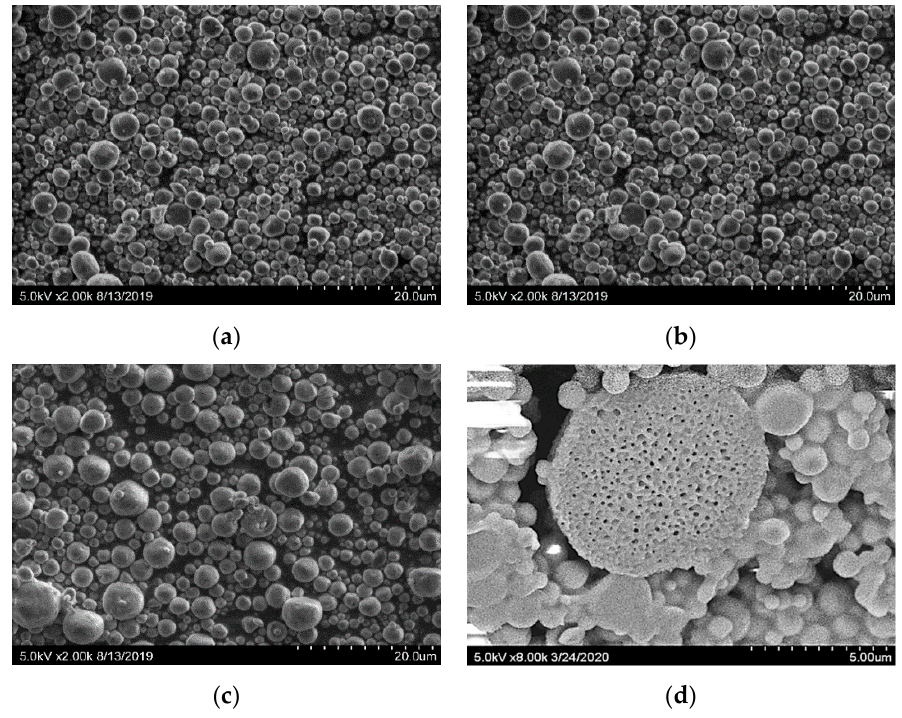
Figure 1. Scanning electronic microscopy (SEM) images of tangeretin in citrus pectin and sodium alginate matrix microcapsules. ( a ): Control (no tangeretin); ( b ): low tangeretin; ( c ): high tangeretin; ( d ): inner structure of the investigated microcapsules.